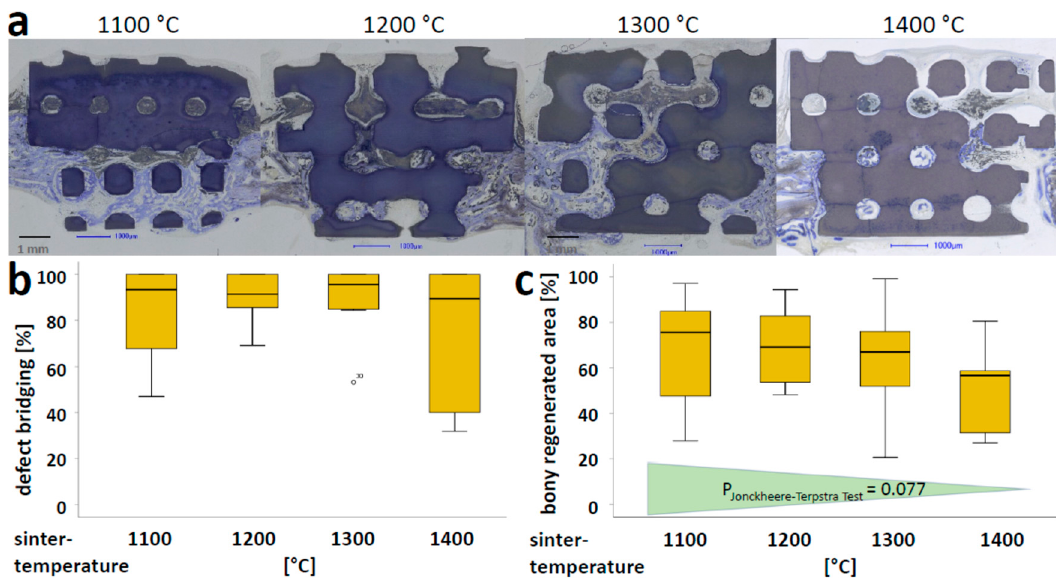
Figure 2. Microporosity-dependent osteoconduction and bone regeneration: ( a ) Histological sections from the middle of the noncritical-size defects treated with scaffolds sintered at 1100, 1200, 1300 or 1400 °C. Histological section from 4 weeks postoperatively is shown. Scale bars represent 1 mm. Bone (grayish purple to purple) and HA (dark bluish to black) are visualized; ( b ) defect bridging and ( c ) the formation of new bone, are displayed according to [10]. For bony regenerated area ( c ), a weak trend of a decrease in bony regenerated area with increased sintering temperature was recognized. The p -value of the Jonckheere–Terpstra trend test is provided.